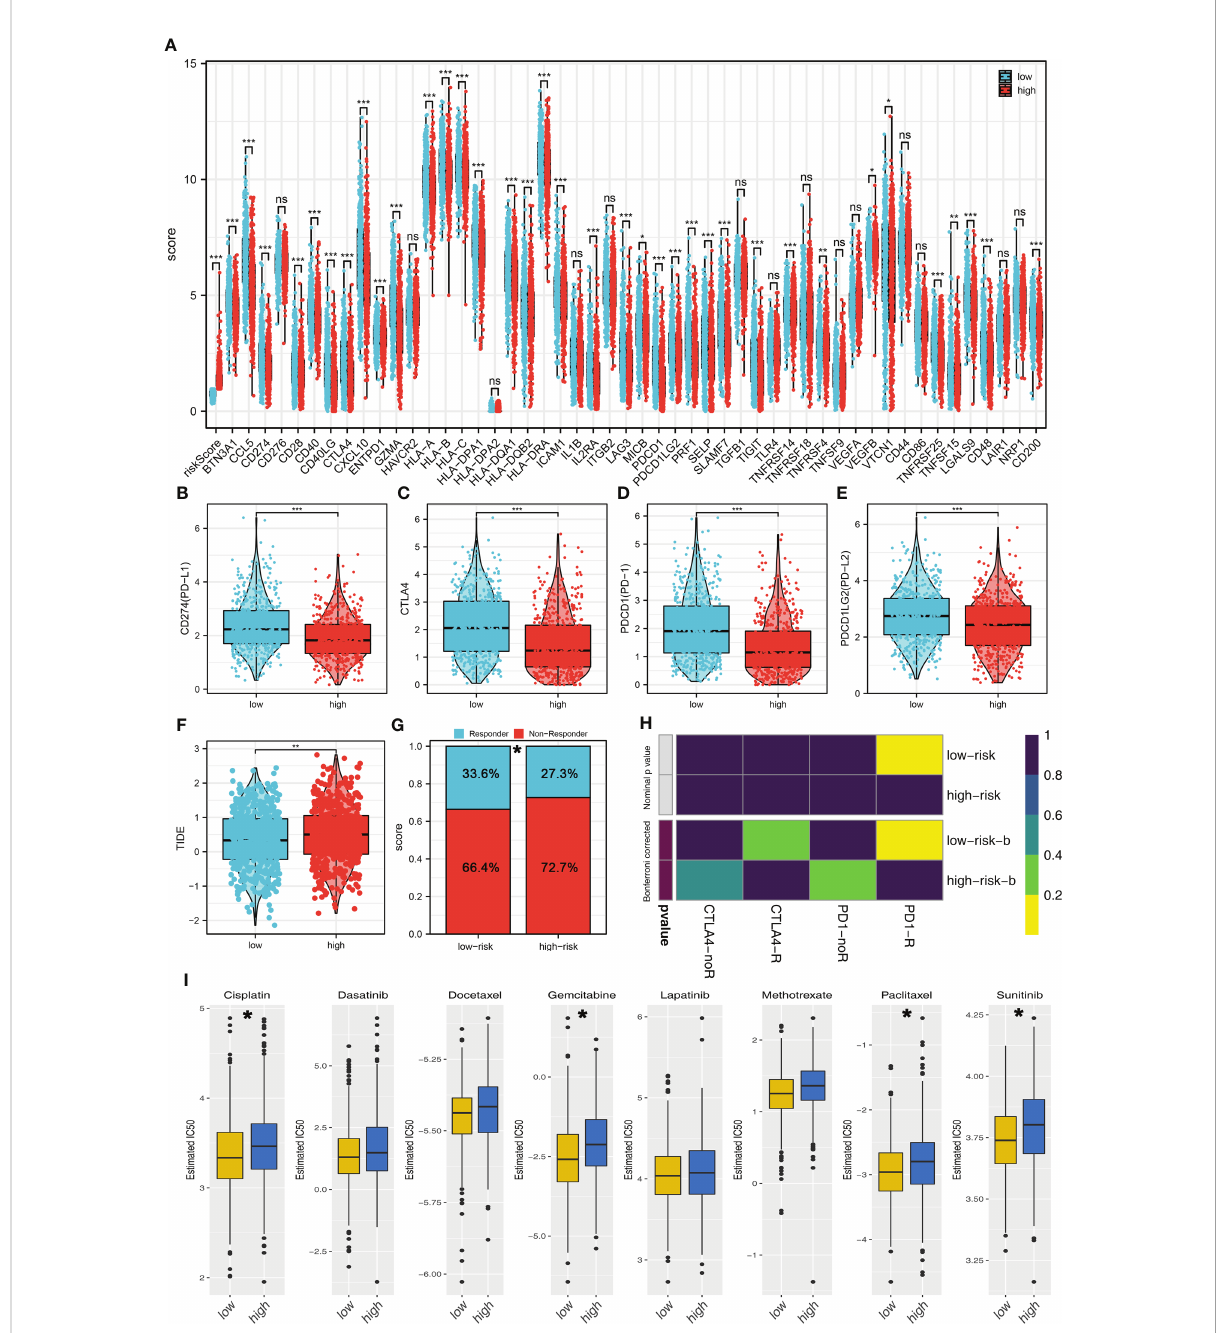
FIGURE 6 Riskscore was associated with the immunotherapy and chemotherapy sensitivity (A) The expression difference of immune checkpoints in high- and low-risk groups. (B – E) PD-L1, CTLA-4, PD-1, and PD-L2 were all highly expressed in the low-risk group. (F) The TIDE score in high- and low-risk groups. (G) Low-risk patients have a higher percentage of immunotherapy responders. (H) Submap algorithm indicated that the low- risk patients might be more sensitive to PD-1 therapy. (I) GDSC analysis showed that low-risk patients might be more sensitive to cisplatin, gemcitabine, paclitaxel, and sunitinib. *P < 0.05; **P < 0.01; ***P <